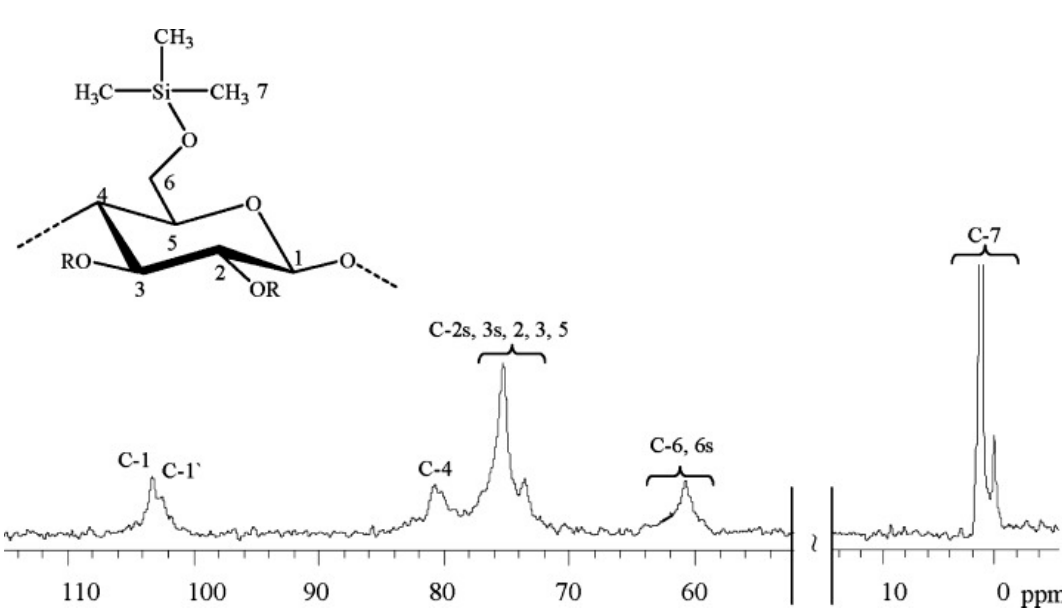
Figure 5. 13 C NMR spectrum of trimethylsilyl cellulose (degree of substitution, DS ≈ 0.43) in DMSO-d 6 , R means trimethylsilyl group or H according to DS. Reproduced from [45,46] with permission from Wiley and Copyright Clearance Center, 2008.